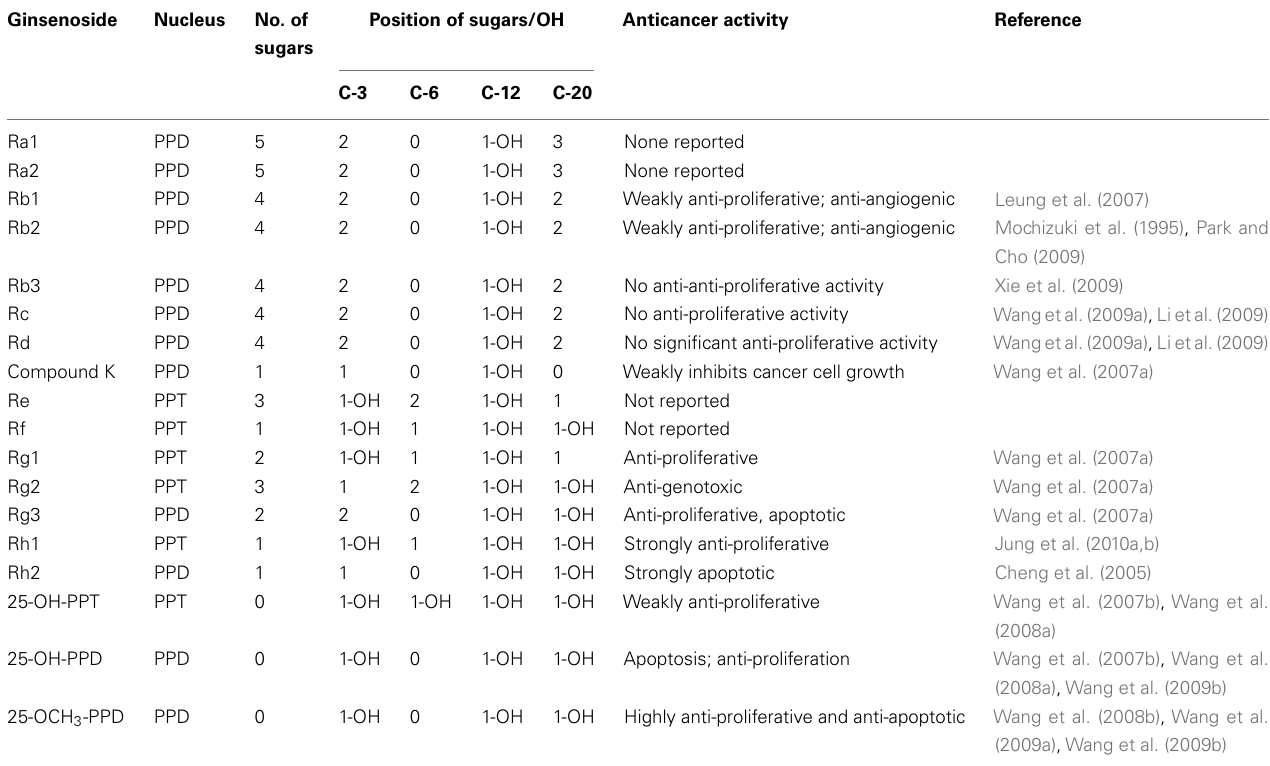
Table 1 | Possible structure–activity relationships of ginsenosides against cancer.